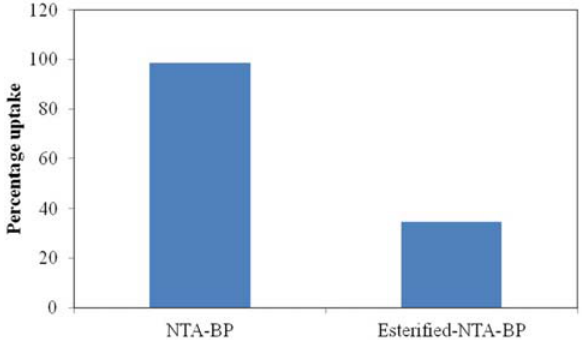
Figure 3. Effect of esterification on the adsorption of MB by NTA- BP